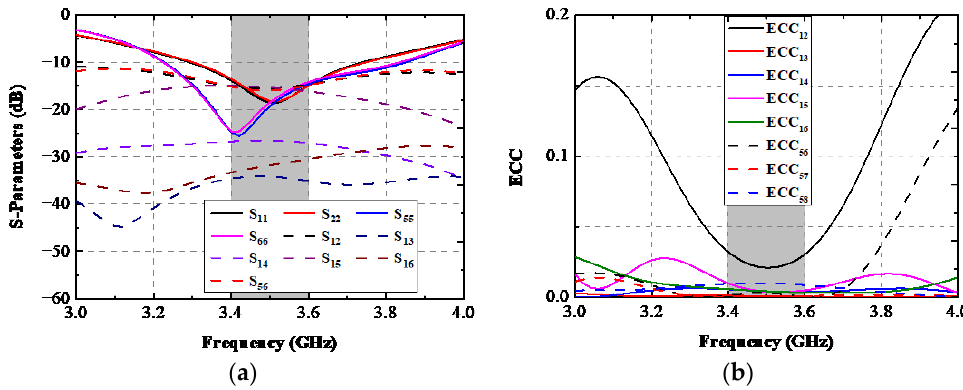
Figure 18. Simulated ( a ) S-parameters and ( b ) ECCs of the 8-port APs system.